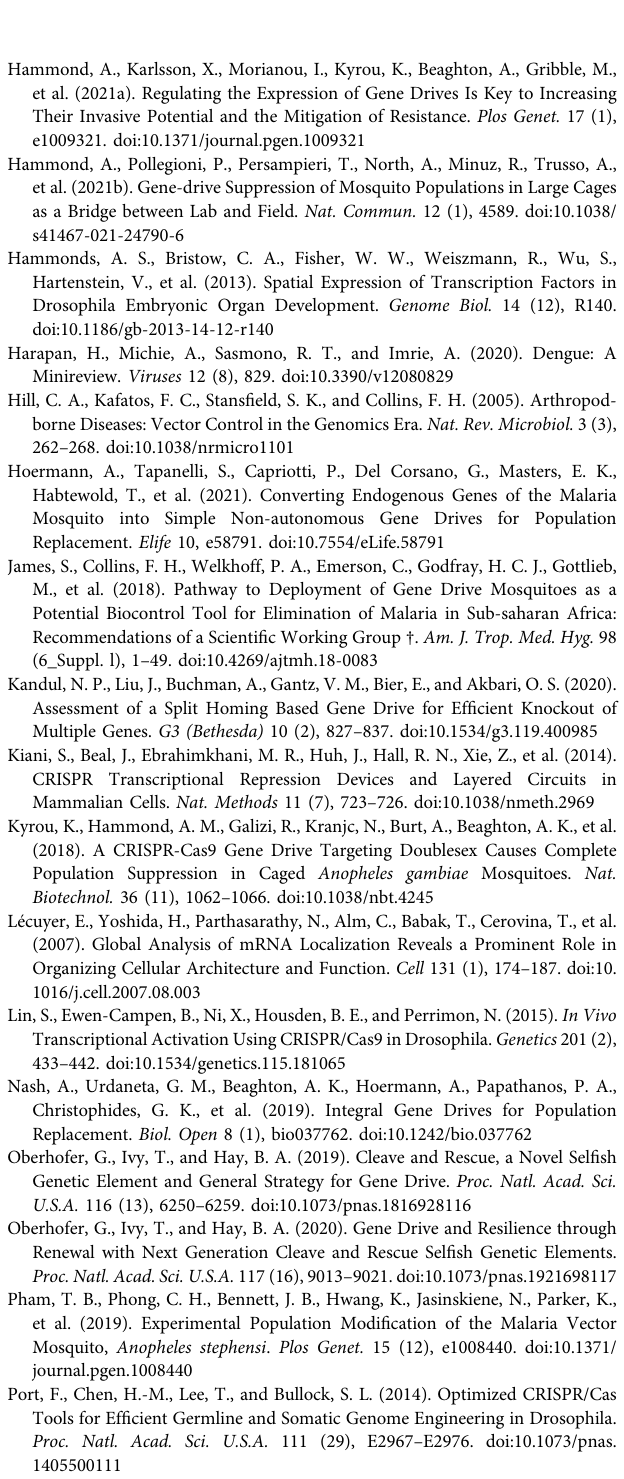
Supplementary Figure S1 | Testing intronic gRNA designs in the presence of the activation control to determine splicing levels. Relative mean eGFP fl uorescence and SD from triplicate transfections of each intronic gRNA variant, using either ftz or minimal introns. The p values were calculated using one-way ANOVA and Tukey multiple comparisons of means (* p < 0.05; ** p < 0.01; and *** p <